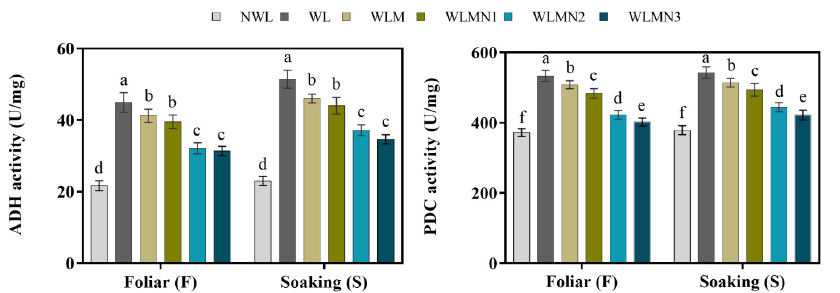
Figure 6. ADH and PDC activities of maize seedlings under waterlogging stress conditions. Data are presented as mean ± SD ( n = 3, biological replicates). Different small letters (a,b,c,d,e) in each column indicate significant differences at p ≤ 0.05 (least significant difference (LSD) test).The abbre- viations of treatment names are the same as those described in Table 2.